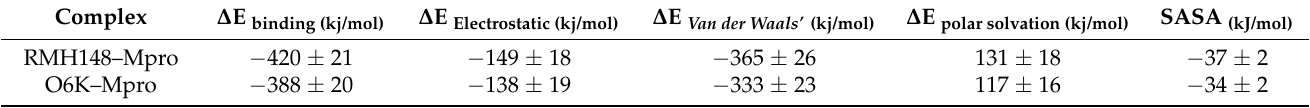
Table 2. The binding free energy for the complexes of RMH148–Mpro and O6k–Mpro, using MMPBSA calculations. Complex ∆ E binding